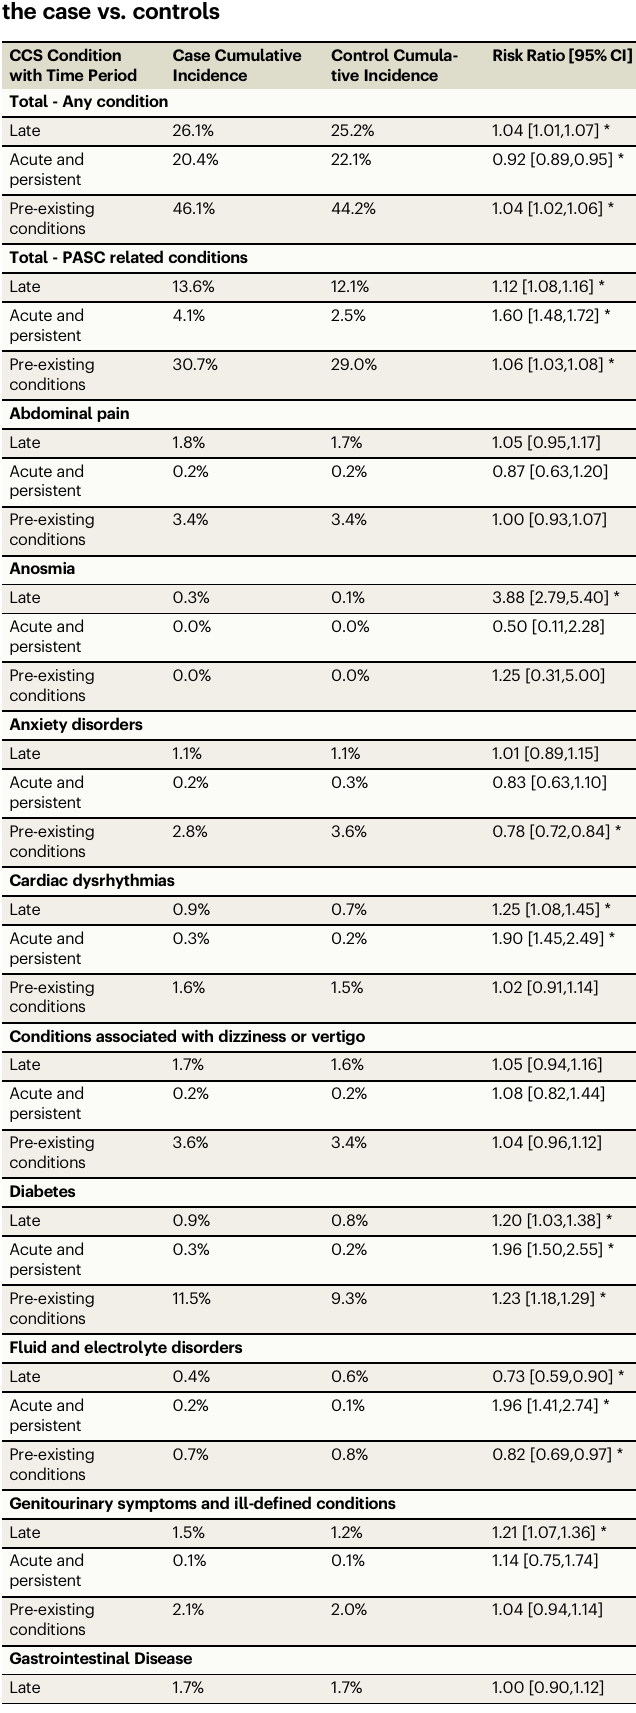
Table 4 (continued) | Risk and cumulative incidence of CCS categories in the case vs. controls